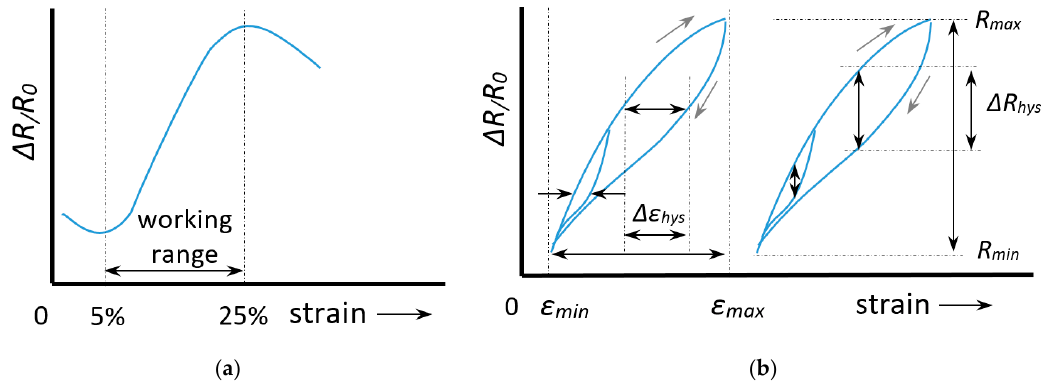
Figure 6. Definitions of: ( a ) Working range; ( b ) Horizontal and vertical hysteresis.